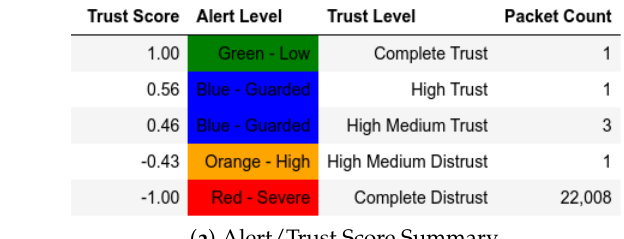
Figure 32. Server: ATENA H2020 dataset internal test with IP-MAC blocking- H a in query flooding capture-unknown write attack.